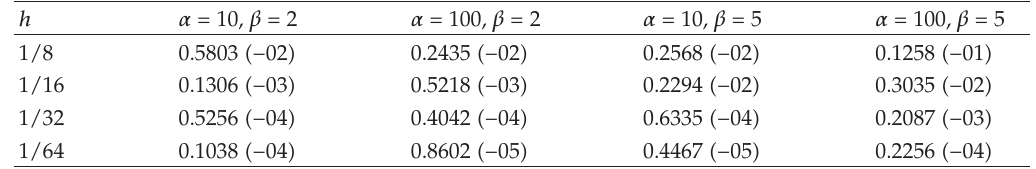
Table 10: RMS errors of the scheme in (cid:6) 33 (cid:7)